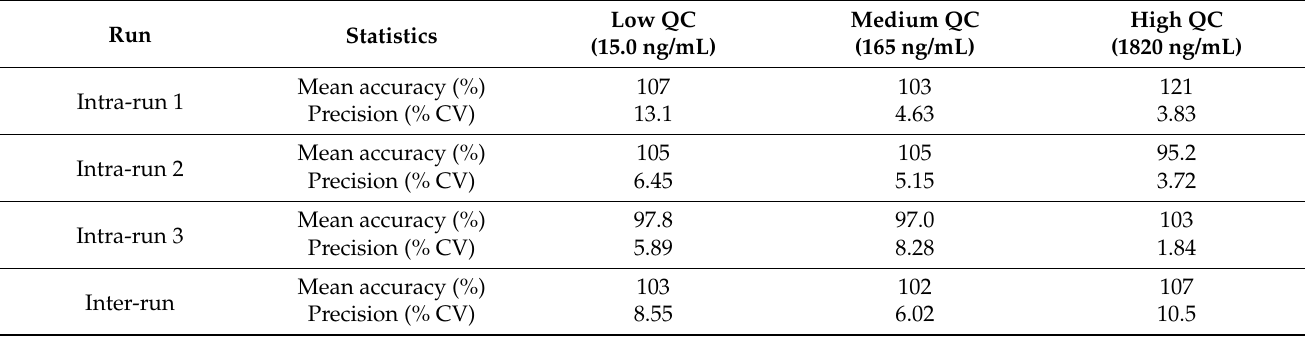
Table 1. QC results and statistics from the intra/inter ‐ run assays for α‐ amanitin in rat plasma.